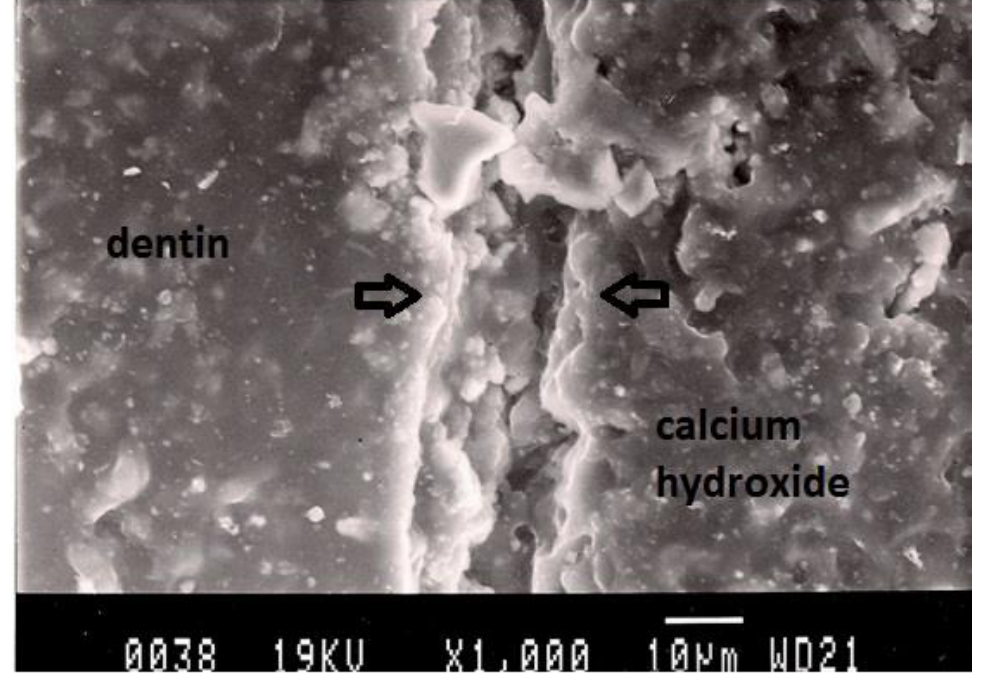
Figure 4. Representative SEM photomicrograph of a Group 3 specimen. The arrows indicate microgap between calcium hydroxide (Dycal) and dentin.